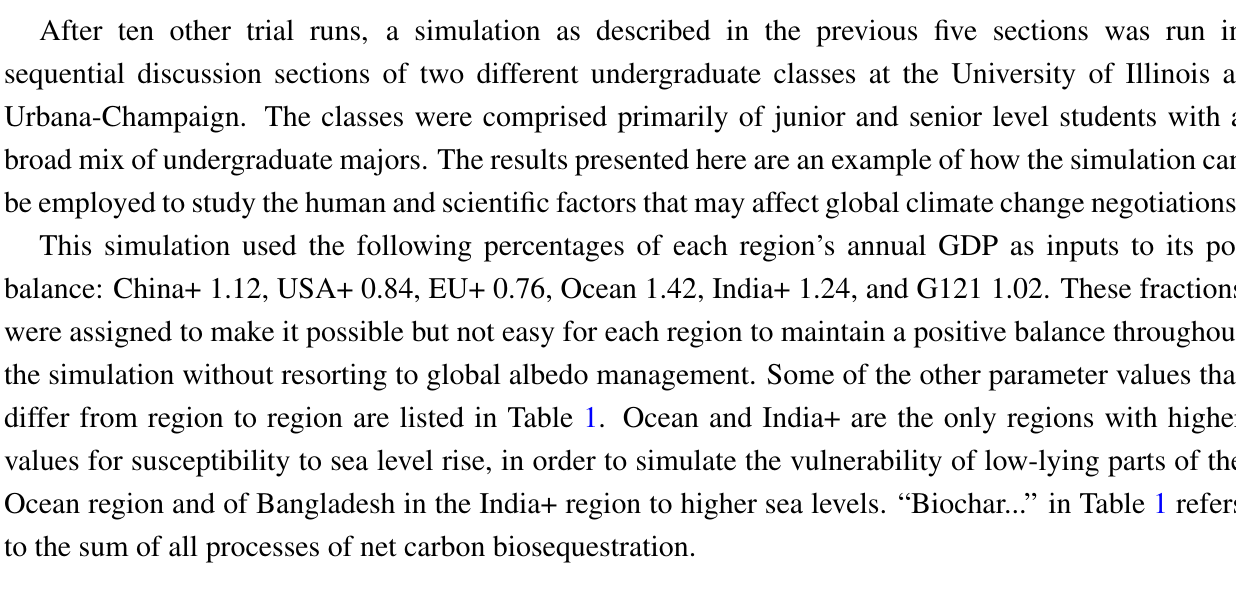
Table 1. Region dependent